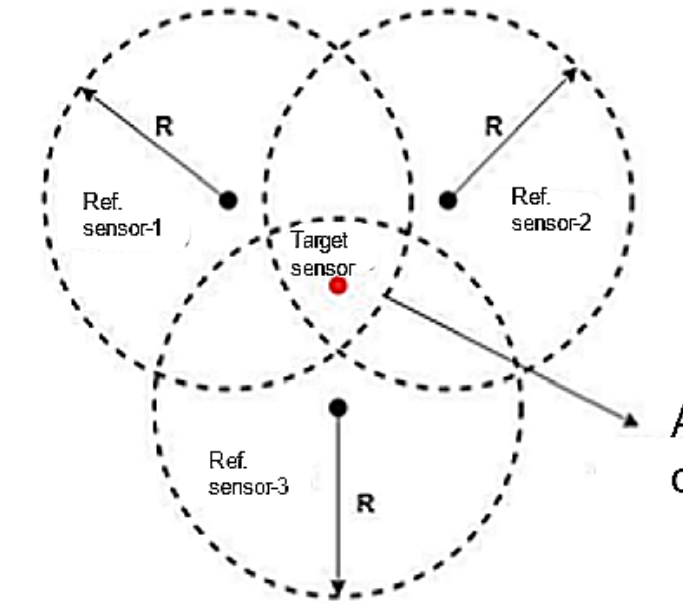
Figure 18. Structure of a Sensor on the Robot Graphically.